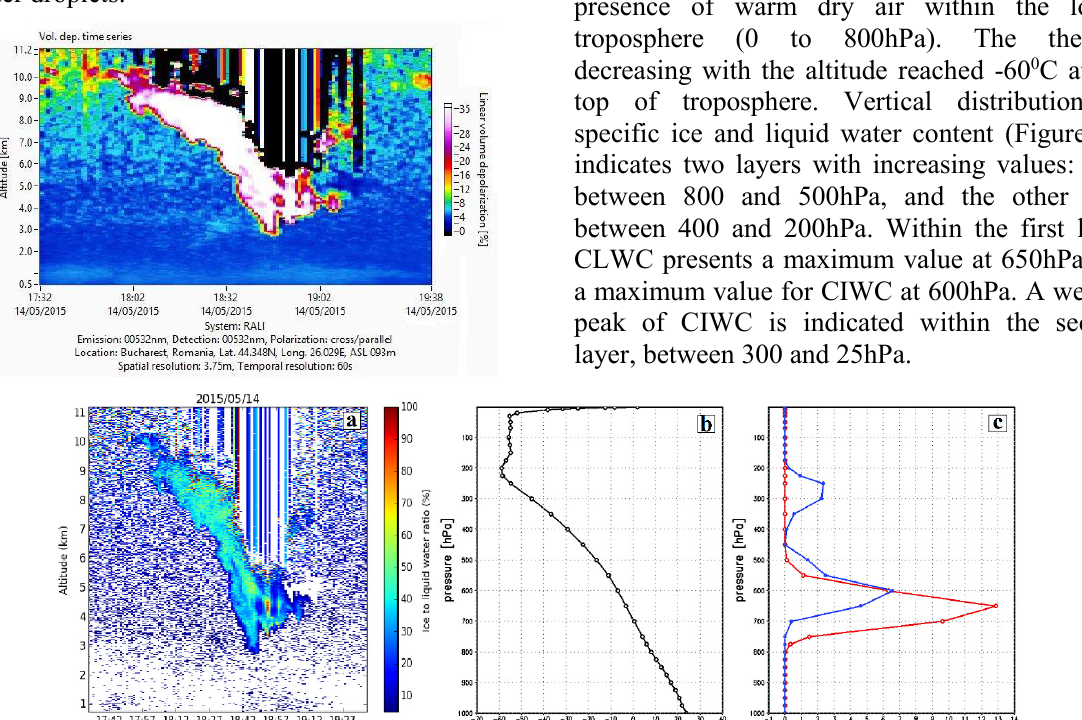
Figure 3 Lidar time series of VDR for May 14 th 2015